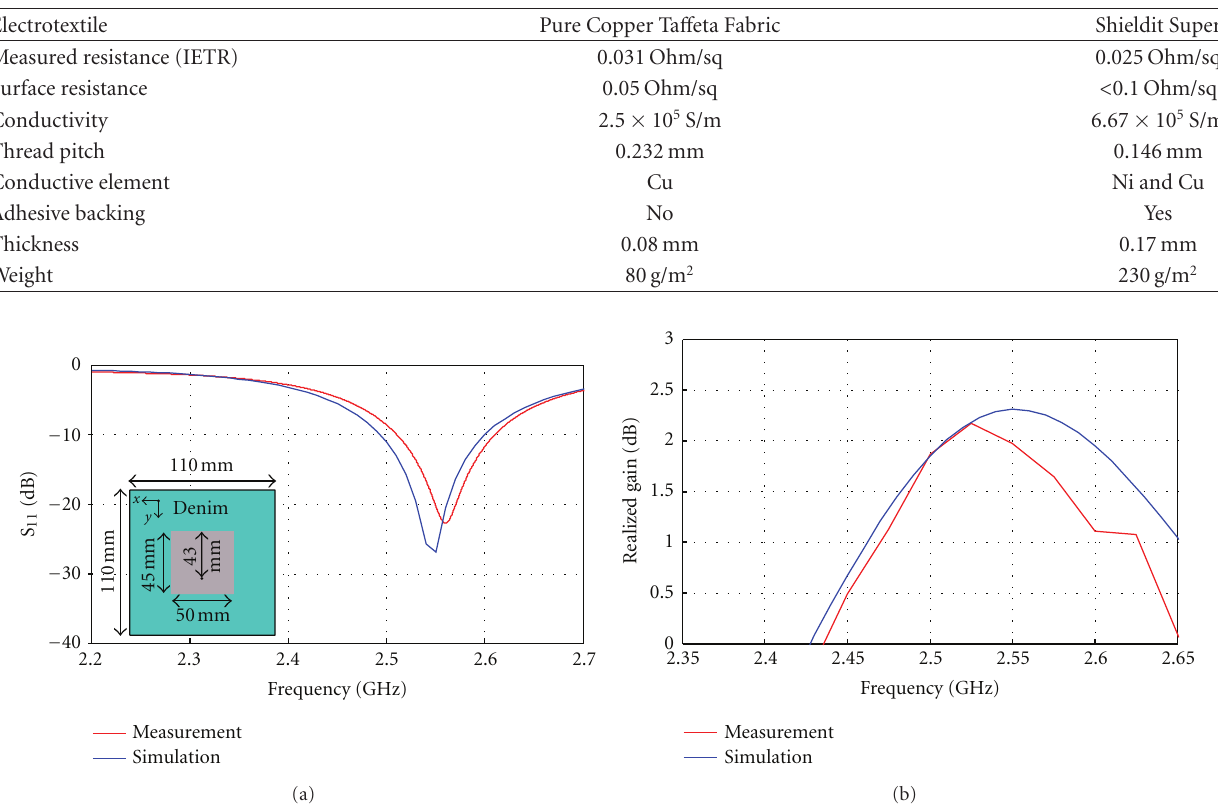
Figure 9: Prototype geometry description and characterization results for patch antenna on denim: return loss (a) and realized gain (b).